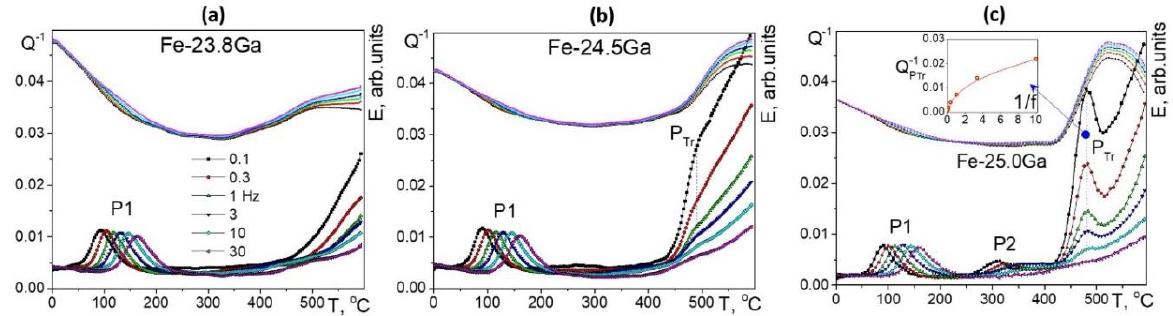
Figure 17. TDIF curves at heating with a rate of 2 °C/min for the Fe–23.8Ga ( a ), Fe–24.5Ga ( b ), and Fe–25.5Ga ( c ) alloys. The dependence of the peak height on inverse frequency for the alloy with 25.5%Ga (inset to ( c )) [60].